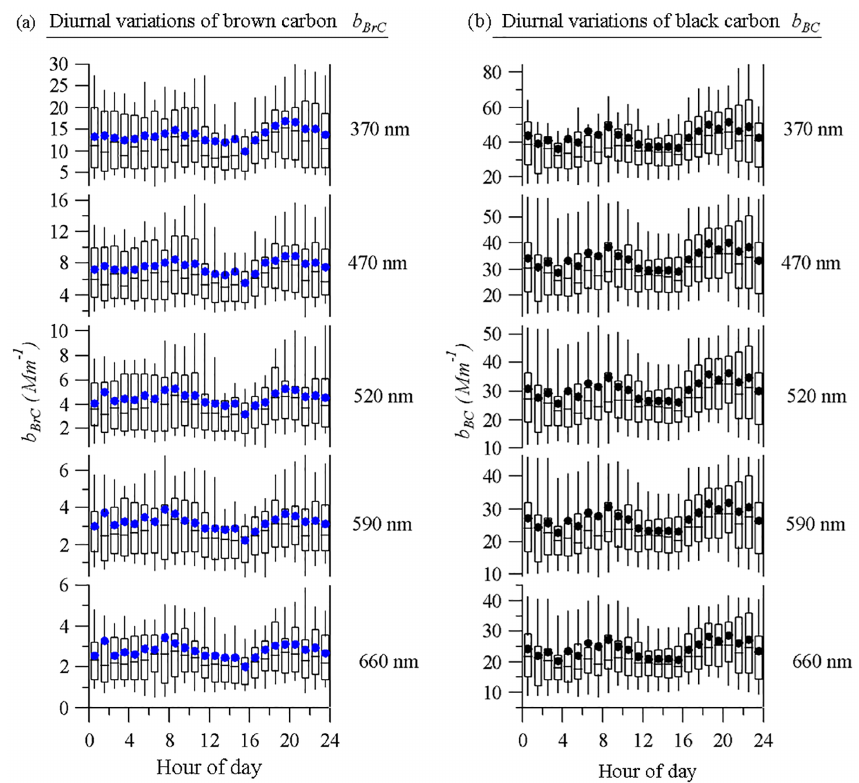
Figure 4. Diurnal variations of BrC and BC light absorption coefficients ( b BrC and b BC ) at different wavelengths. Table 1. Multilinear regression analyses between b BrC at each wavelength and mass loading of different OA factors from AMS-PMF/ME-2. 370nm 470nm 520nm 590nm 660nm Correlation Contribution Correlation Contribution Correlation Contribution Correlation Contribution Correlation Contribution factor to factor to factor to factor to